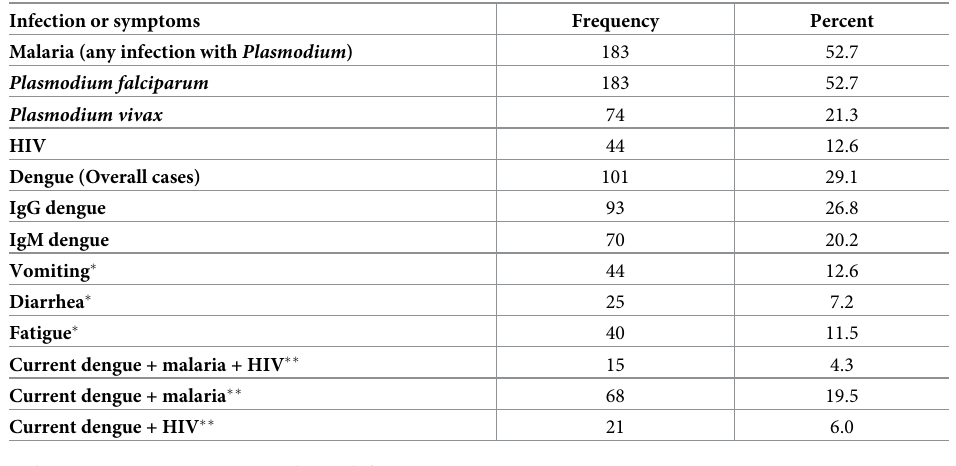
Table 2. Overall prevalence or seroprevalence of different infections, co-infections and symptoms among the study participants. Infection or symptoms